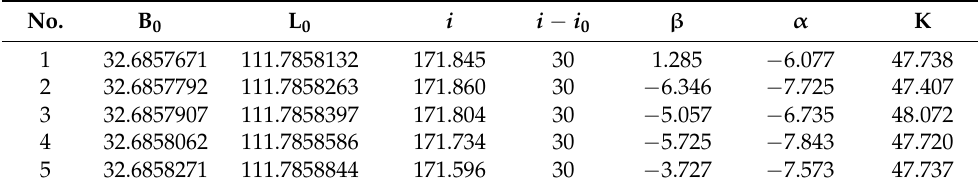
Table 3. Example of M300 ground-like flight POS